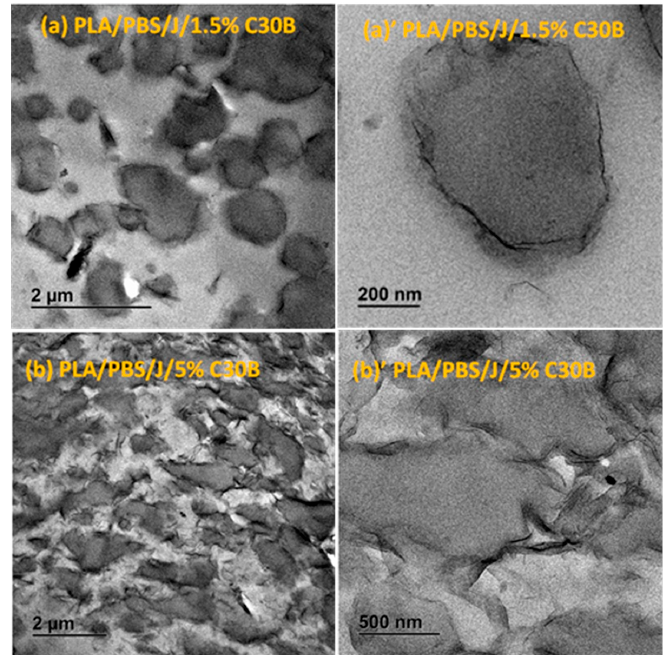
Figure 5. TEM images of the ( a , a’ ) PLA/PBS/J/1.5%C30B and ( b , b’ ) PLA/PBS/J/5%C30B blends. ( a’ ) and ( b’ ) are the high-magnification localized images of 1.5 wt % C30B (scale bar = 200 nm) and 5 wt % C30B (scale bar = 500 nm) blends. C30B is Cloisite ® 30B and J is Joncryl.